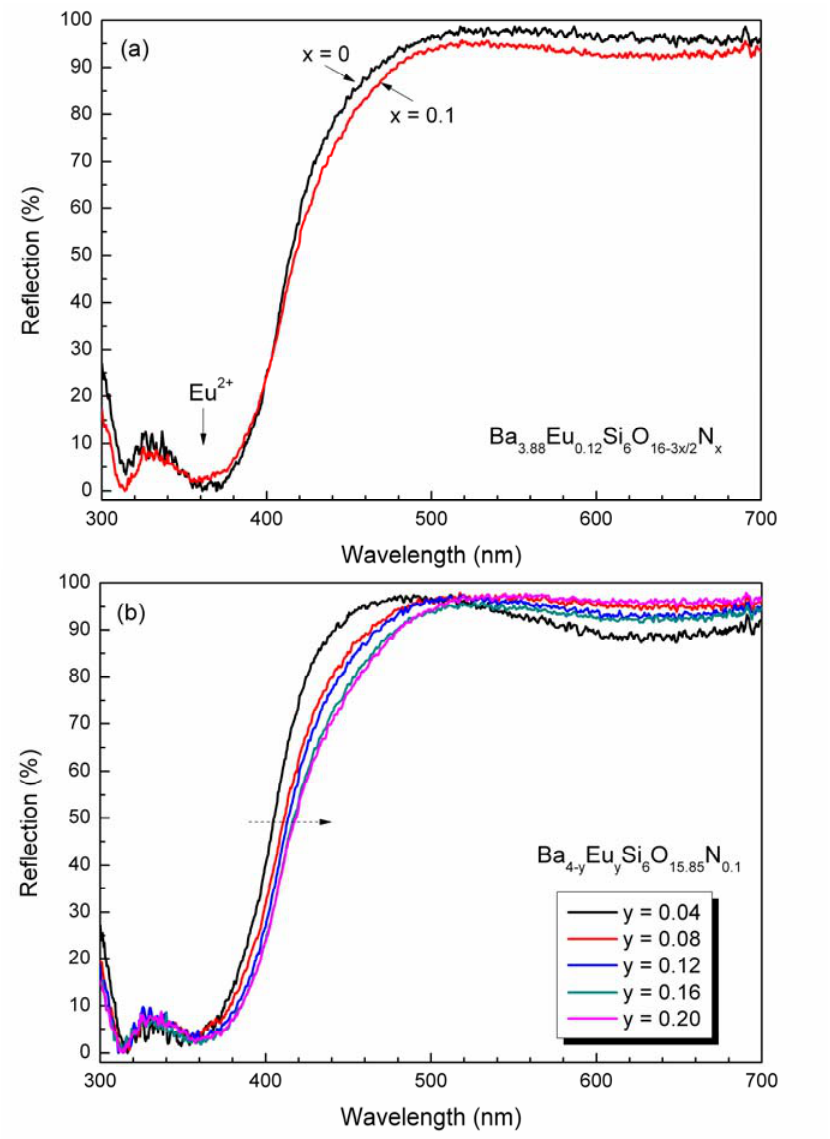
Figure 6. Diffuse reflection spectra of Ba nitrogen content (x), and (b) the Eu 2+ concentration